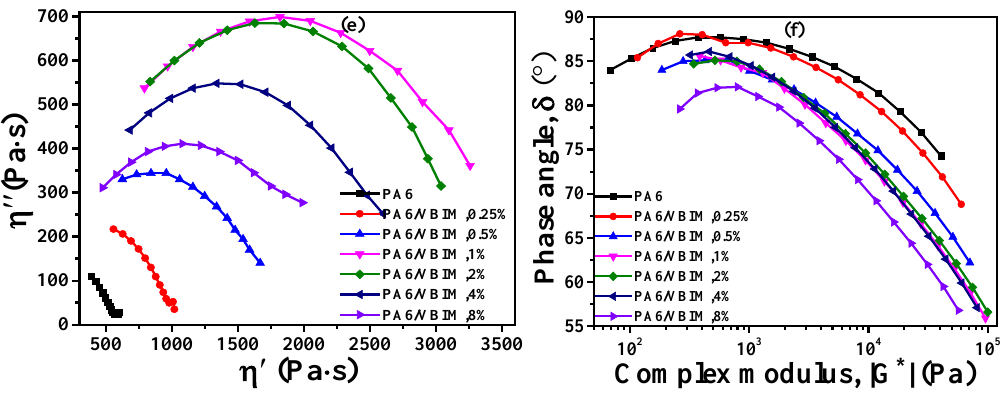
Figure 6. Linear viscoelastic properties from SAOS experiments: ( a ) storage modulus G′; ( b ) loss modulus G ″; ( c ) complex viscosity |η*|; ( d ) damping factor tan δ as functions of angular frequency; ( e ) Cole-Cole plots; and ( f ) vGP plots.